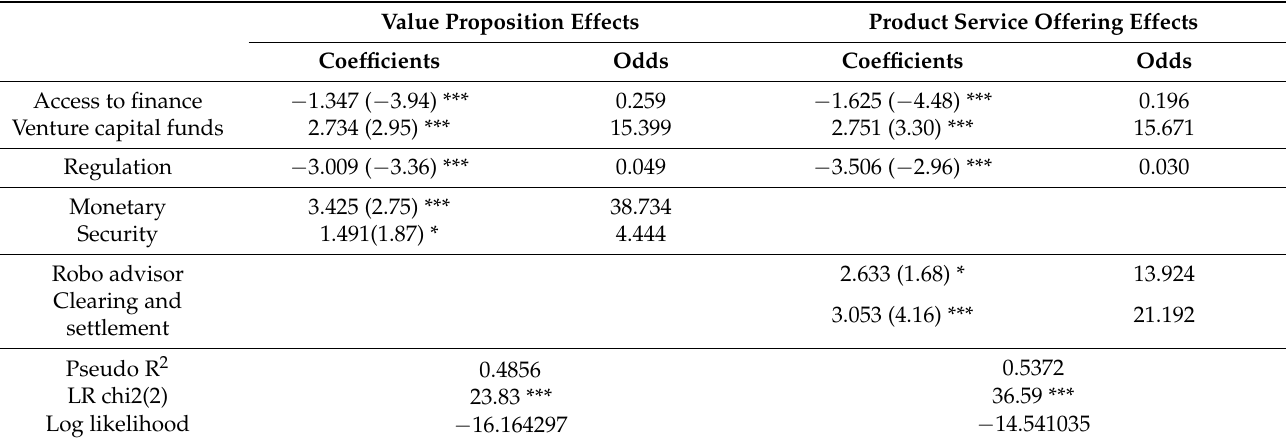
Table 3. Excerpt from the OL regression analysis showing the significant business model dimensions affecting FinTechs’